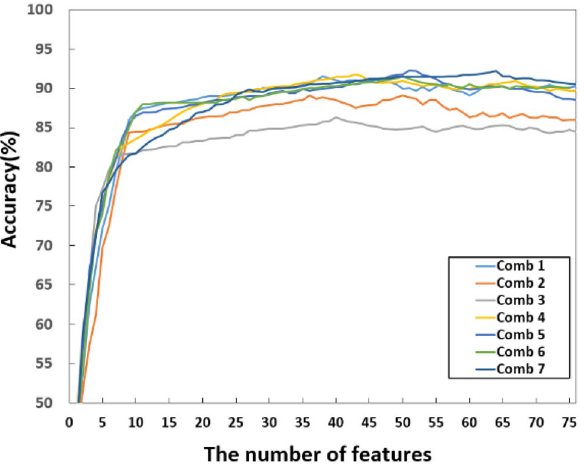
Figure 6. Feature selection with SFFS for feature-level fusion approaches across different data domains.